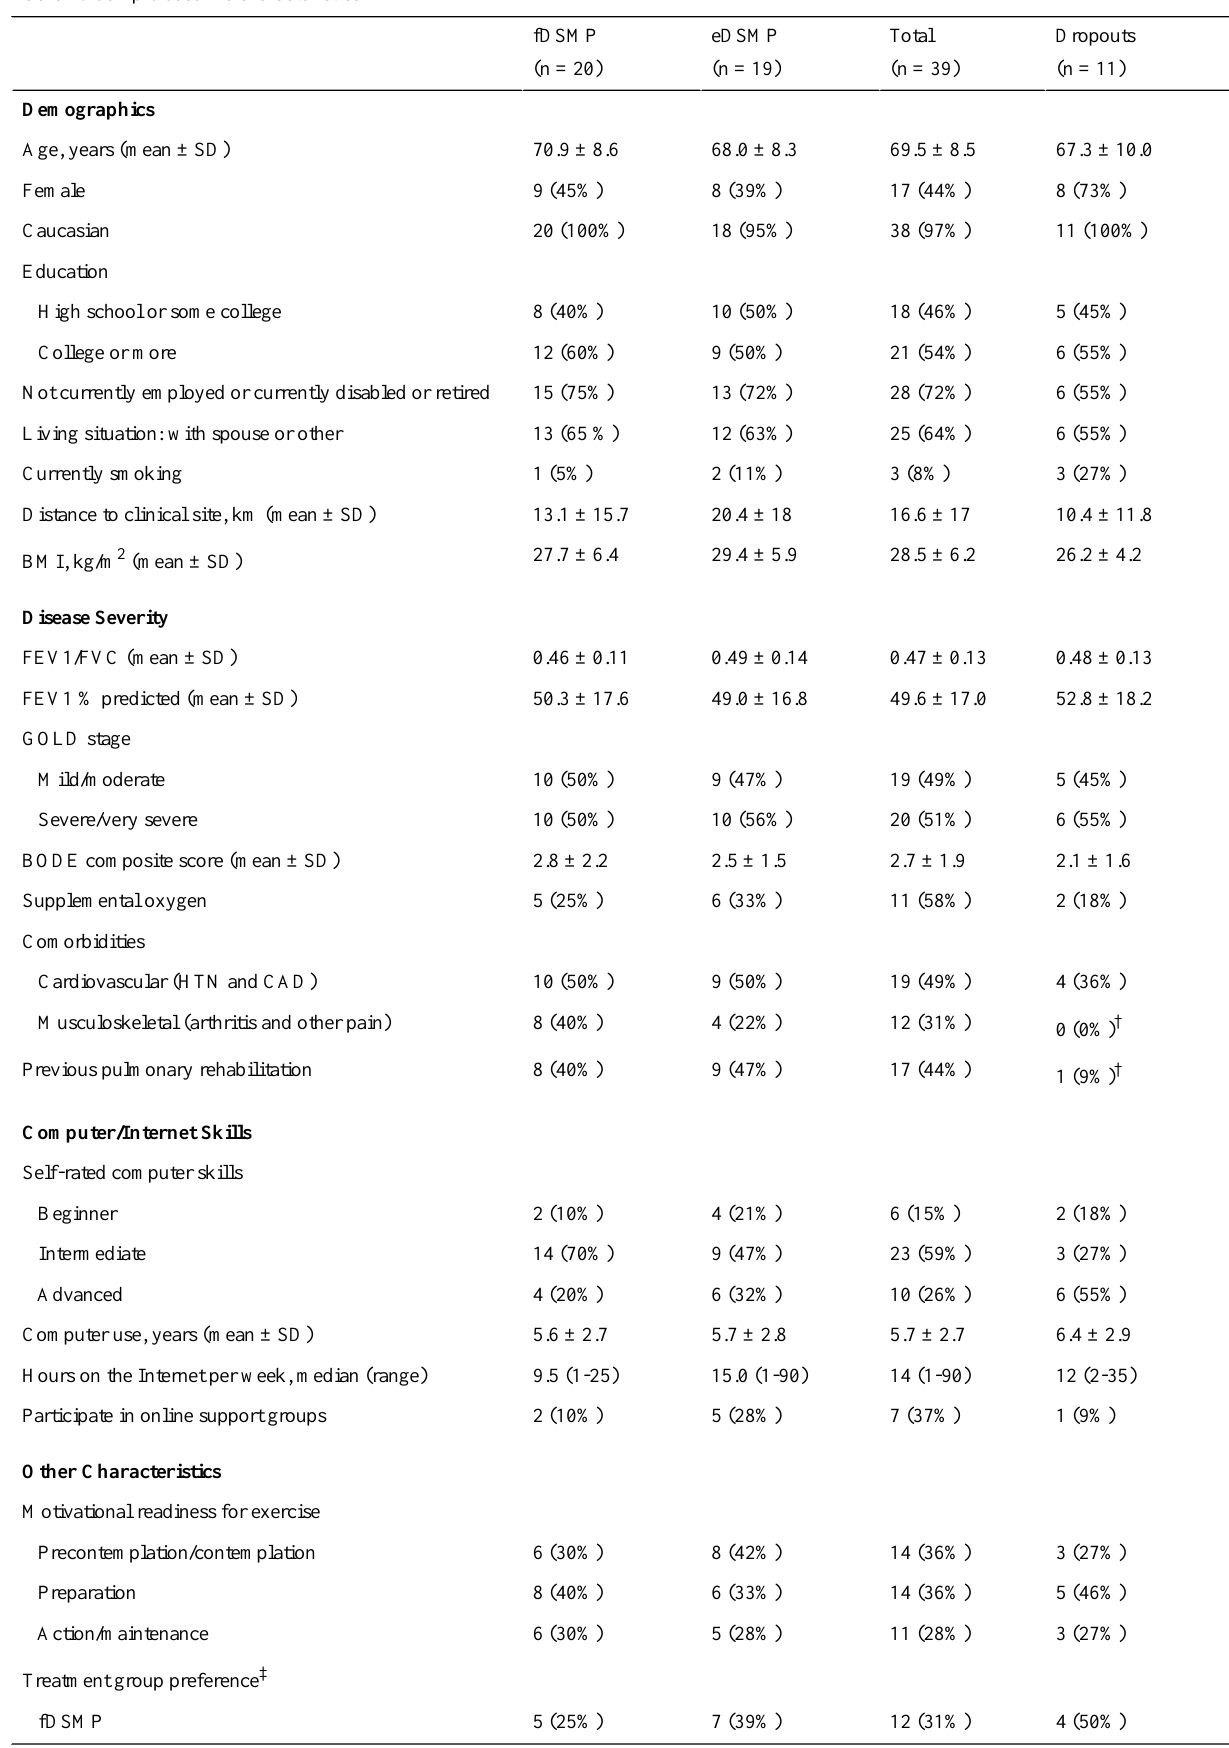
Table 2. Sample baseline characteristics*